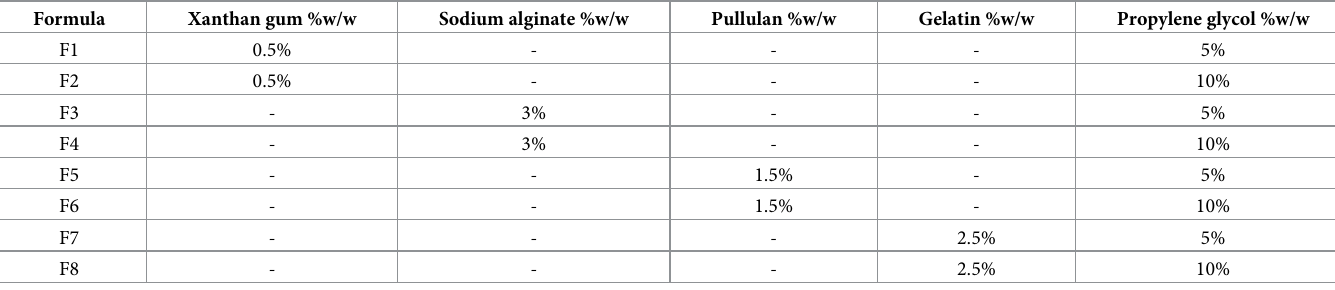
Table 1. Composition of medicated fast dissolving film containing eszopiclone.